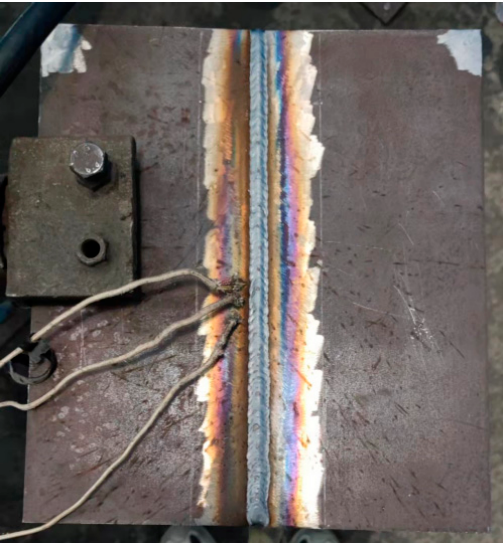
Figure 3. Temperature field measurement. After the welding, the residual stresses were measured using the hole-drilling (HD) method. Figure 4 shows the positions of the residual stress measurements. The type of strain gage was BE120-2CA-K. The parameters of the strain gage were resistance of 120.2 ± 0.3 and gage factor of 2.23 ± 1%. As shown in Figure 3, there were three wire grids facing three directions. The angle of those three wire grids with the welding bead were 0 ◦ , 45 ◦ and 90 ◦ , respectively. Adopting elastic mechanics, the longitudinal stress and transverse stress could be calculated using the measured value of three strain gages [18,19].